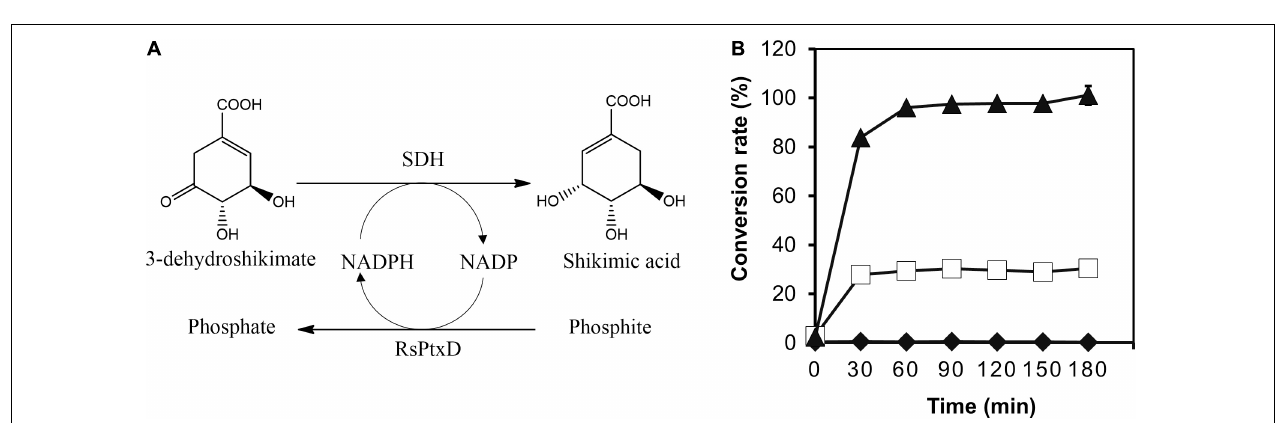
FIGURE 5 | Shikimic acid (SA) production by shikimate dehydrogenase with NADPH regeneration by RsPtxD. (A) A schematic of the coupled reactions of SA production by shikimate dehydrogenase (SDH) and NADPH regeneration by RsPtxD. (B) The batch production of SA from 3-dehydroshikimate by SDH with NADPH regeneration by wild-type RsPtxD (diamonds), RsPtxD AR (squares), and RsPtxD HARRA (triangles). The reaction solutions contained 20 mM phosphite, 8 mM 3-DHS, 0.1 mM NADP, 0.17 U/mL of SDH, and 20 µ g/mL of RsPtxD proteins.